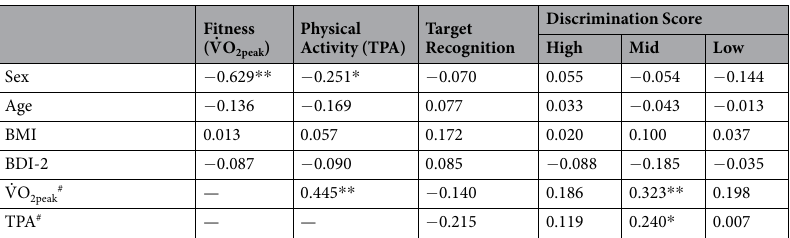
Table 2. Summary of correlation and partial correlation analysis for demographic data, physical activity, fitness, and memory performance. Note: BDI = Beck Depression Inventory;  V O 2peak = Peak Oxygen uptake; TPA = Total Physical Activity. Values are Pearson’s product-moment correlation coefficient. # Partial correlation coefficient controlled for sex as a covariate, * p < 0.05, ** p <